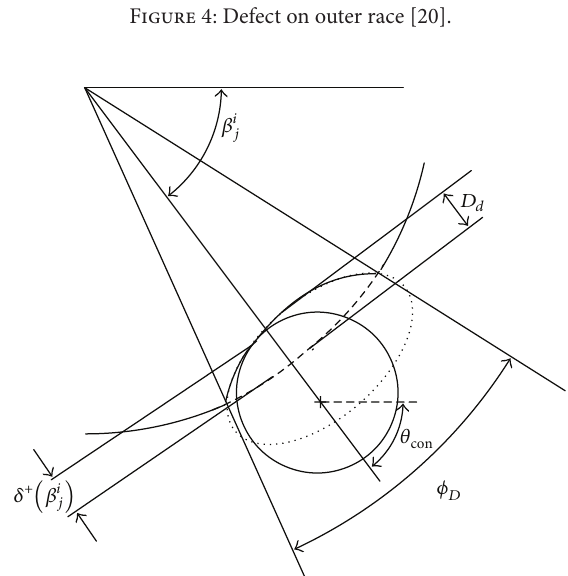
Figure 4: Defect on outer race [20].